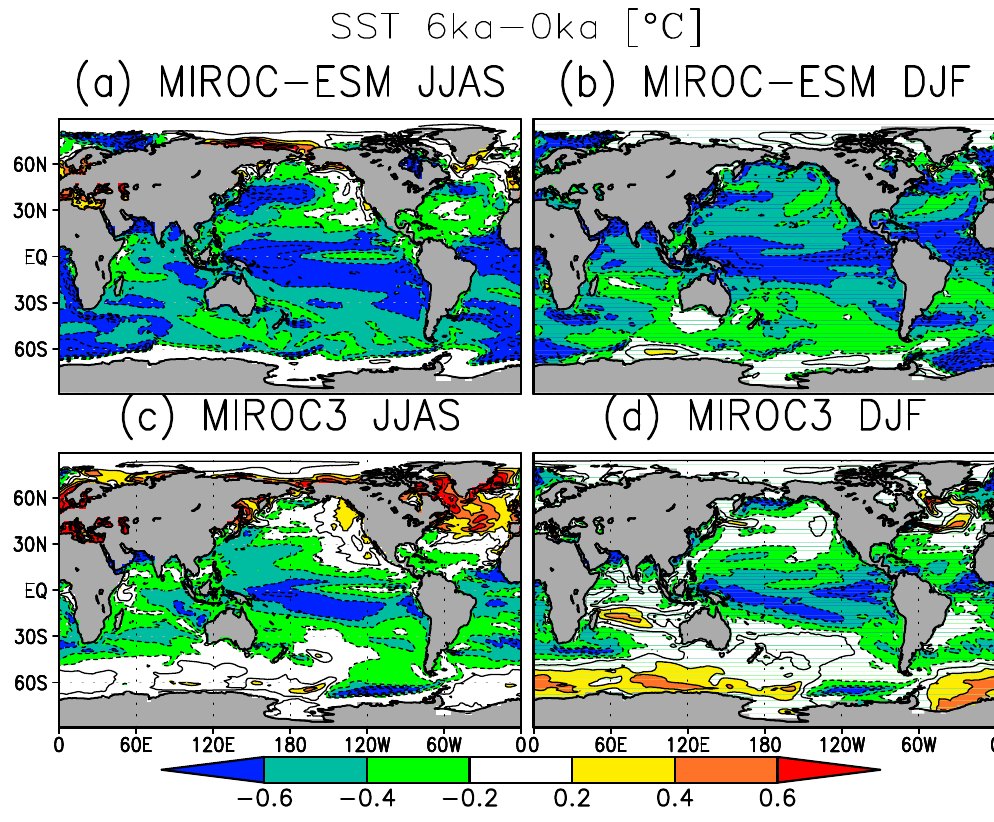
Fig. 7. The same as Fig. 3 but for the SST change ( ◦